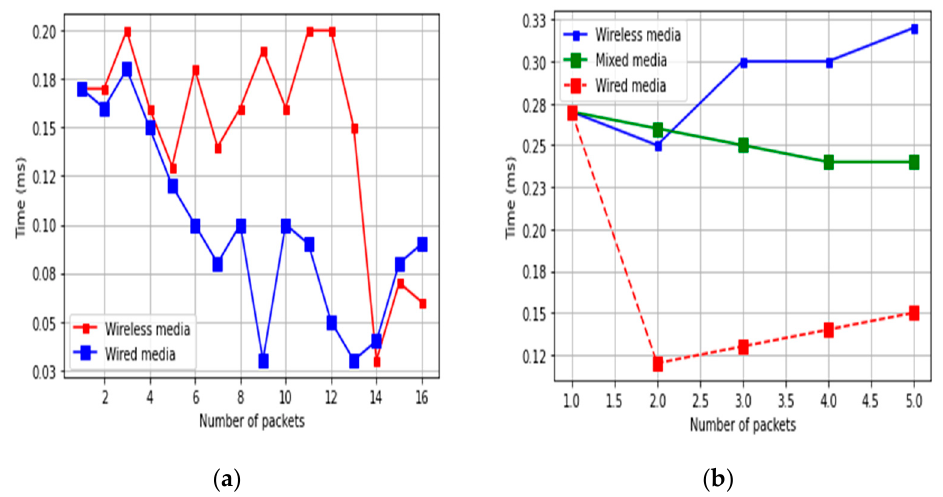
Figure 9. Comparison between wireless and wired media: ( a ) wired/wireless media, and ( b ) wired/wireless and mixed media.